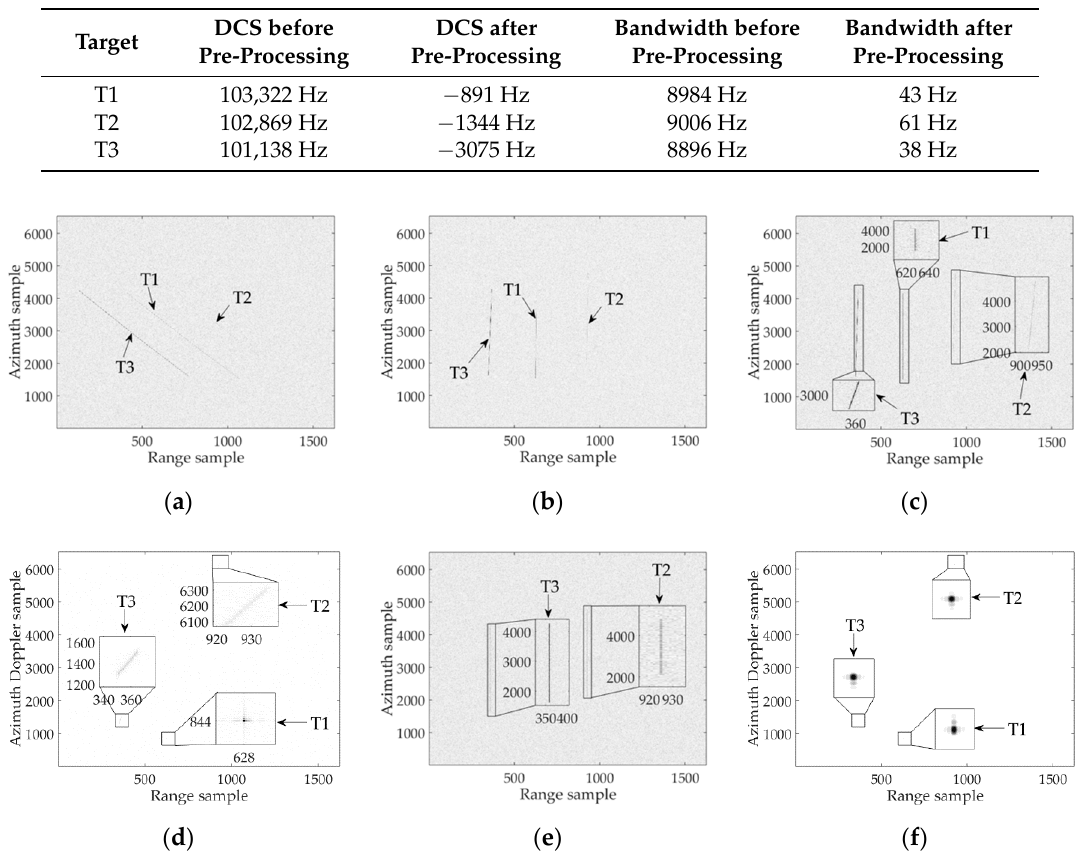
Table 5. DCS and bandwidth for moving targets.